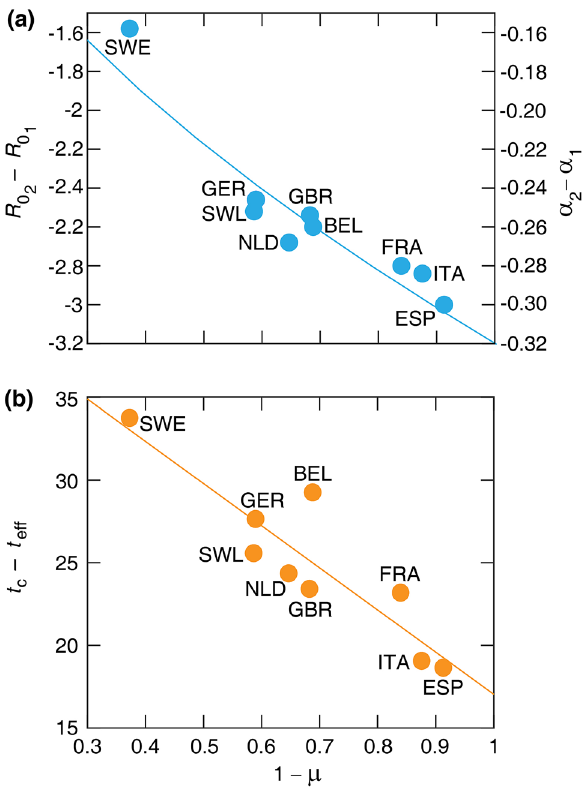
Figure 5. Relationships between key parameters of the COVID-19 pandemics and mobility data. ( a ) Change − R 0 of basic reproductive number R 0 (left axis) and α 2 − α 1 (right axis) versus the mobility drop 1 − µ . Solid 1 2 line indicates a power-law fit − ζ( 1 − µ) ρ , where ζ = 3.18 ± 0.11 and ρ = 0.56 ± 0.09 . r 2 = 0.85 , ( p = 0.0005 ) . ( b ) Elapsed time between the epidemic peak and the effective lock-down, t c − t eff , versus the mobility drop 1 − µ . Solid line indicates the linear fit Eq. (6), where τ 0 = 17.04 ± 1.62 and η = 1.50 ± 0.40 .